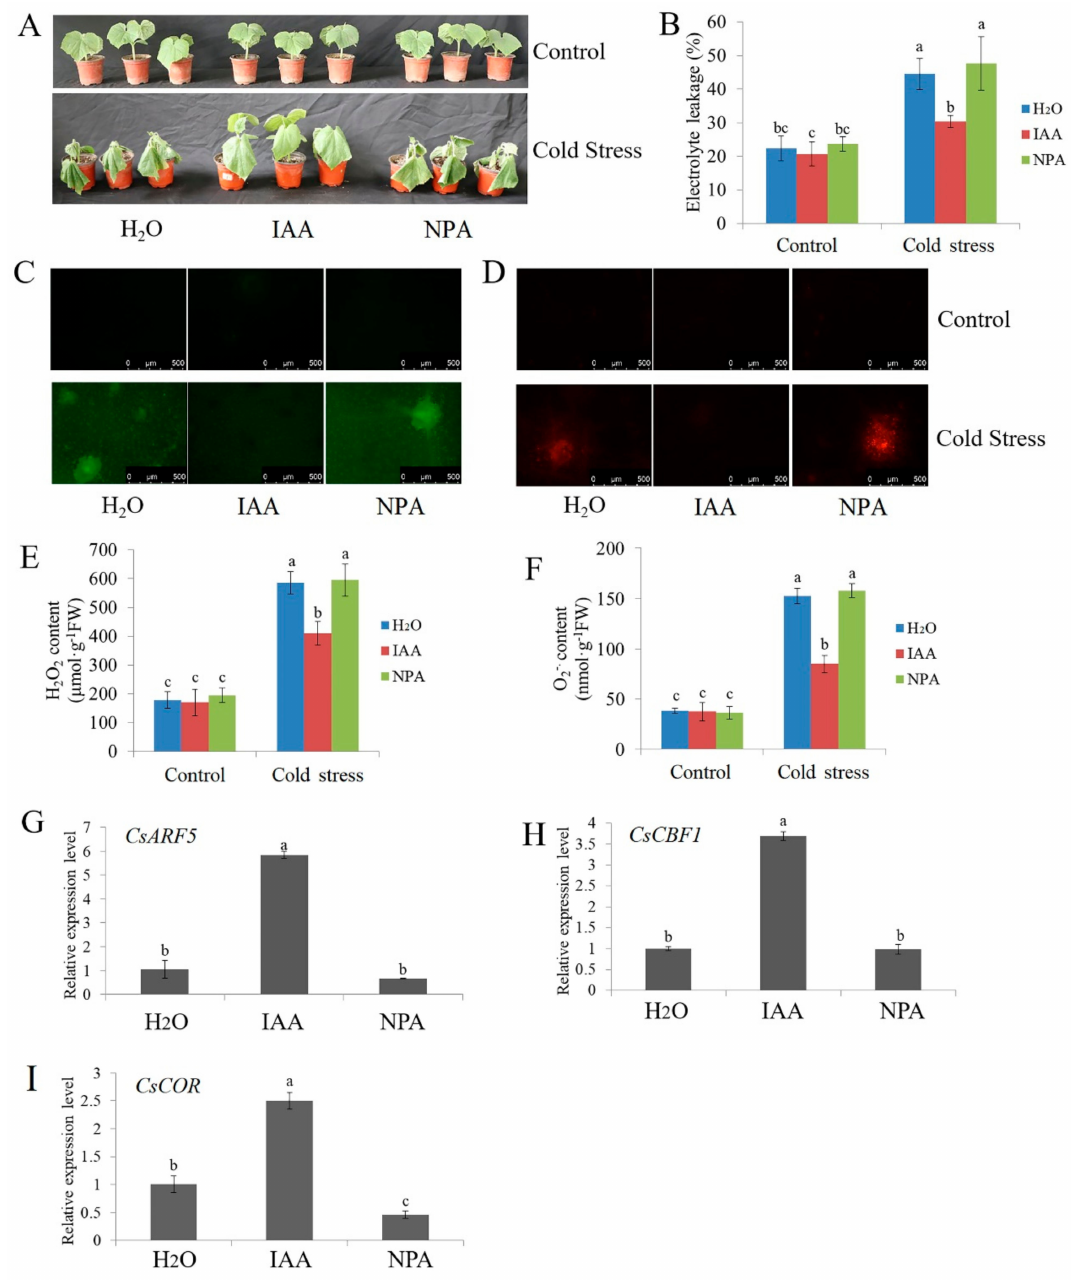
Figure 4. Effects of IAA and NPA on the cold resistance of cucumber seedlings. Cucumber seedlings were treated with IAA, NPA or deionized water for 24 h and subsequently were exposed to cold stress. ( A ) Phenotypic characterization of cucumber seedlings before (control) and after cold stress (5 ◦ C for 48 h). Each treatment contained 5–10 cucumber seedlings. The experiments were repeated three times with similar results. A typical picture is shown here. ( B ) The EL results of cucumber seedlings before (control) and after cold stress treatment for 48 h. ( C , D ) Inverted fluorescence microscopy imaging of H 2 O 2 and O 2 ·− levels in cucumber seedling leaves before (control) and after cold stress treatment for 48 h. ( E , F ) Detection of H 2 O 2 and O 2 ·− accumulation of cucumber seedlings before (control) and after cold stress treatment for 48 h. ( G – I ) Expression of CsARF5 , CsCBF1 and CsCOR genes in cucumber seedlings under cold stress for 6 h. qRT-PCR was performed simultaneously with three biological replicates and three technical replicates. The value of the water treatment was used as the reference and was set to 1. Error bars denote standard deviations. Different letters indicate significant differences ( p < 0.05) based on Duncan’s multiple range